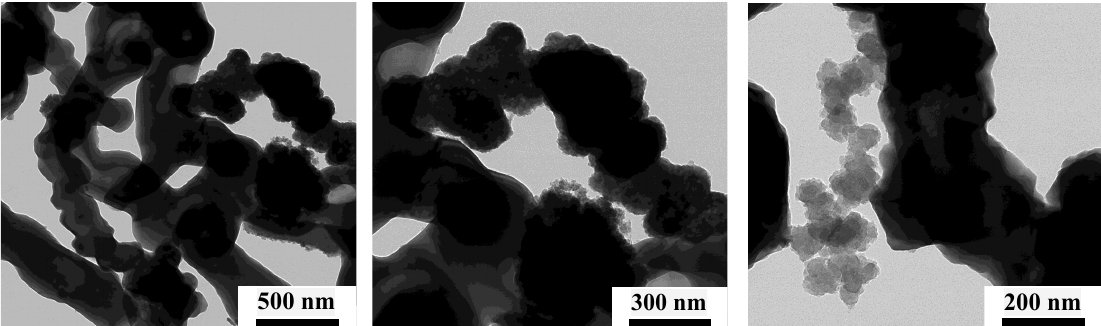
Figure 4. SEM images of µ F at increasing magnifications from left to right .